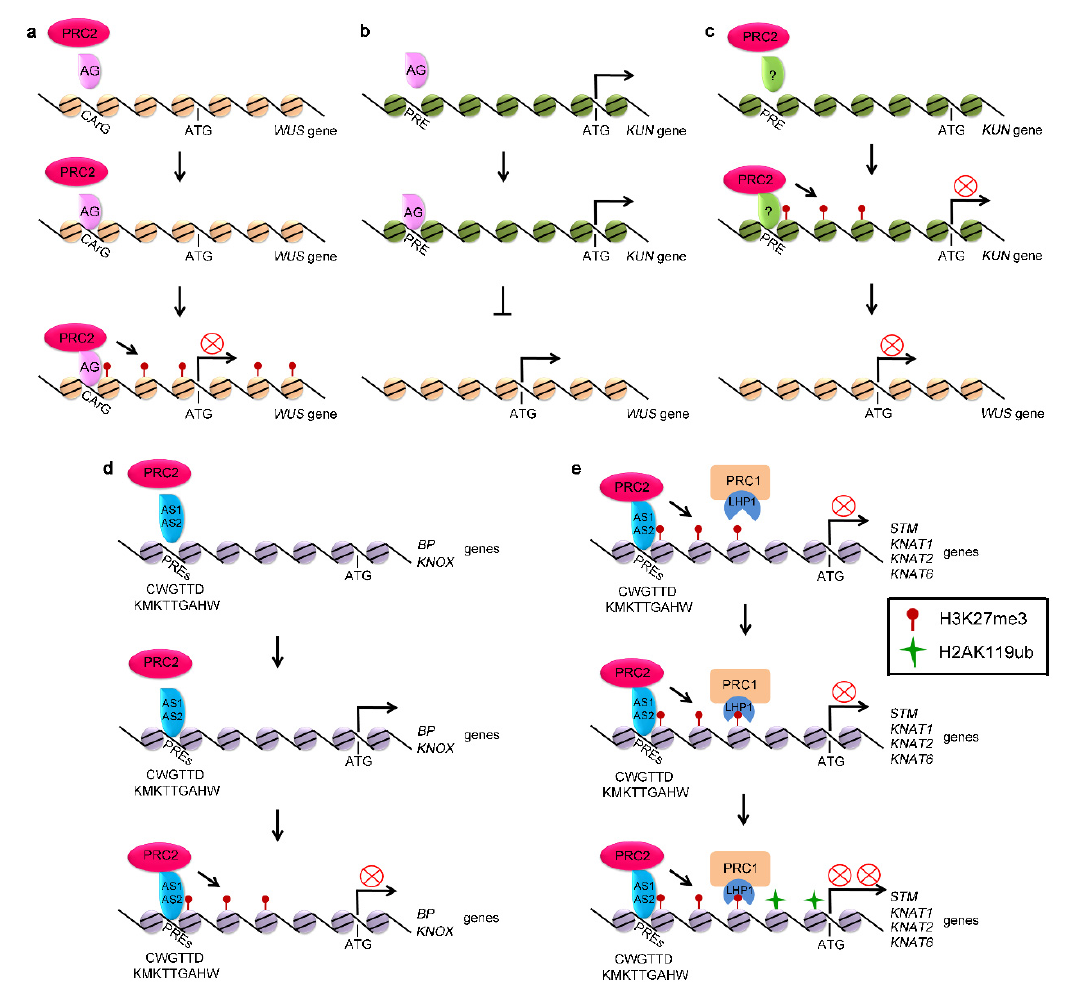
Figure 1. Polycomb-group (PcG) proteins repressed the expression of stem cell fate related genes. ( a ) polycomb repressive complex 2 (PRC2) silences the expression of WUSCHEL ( WUS) through binding to the Polycomb Response Elements (PREs), such as CArG located in the promoter of WUS and generating H3K27me3 at WUS locus. ( b ) AG represses the expression of WUS through activating KUN , a suppressor of WUS . ( c ) PRC2 activates the expression of WUS through silencing KUN , competing with AG. ( d ) PRC2 represses the expression of BP and KNOX genes through binding to PREs, such as CWGTTD and KMKTTGAHW. ( e ) KNOX genes, including STM , KNAT1 , KNAT2 , and KNAT6 genes, marked with H3K27me3 by PRC2.